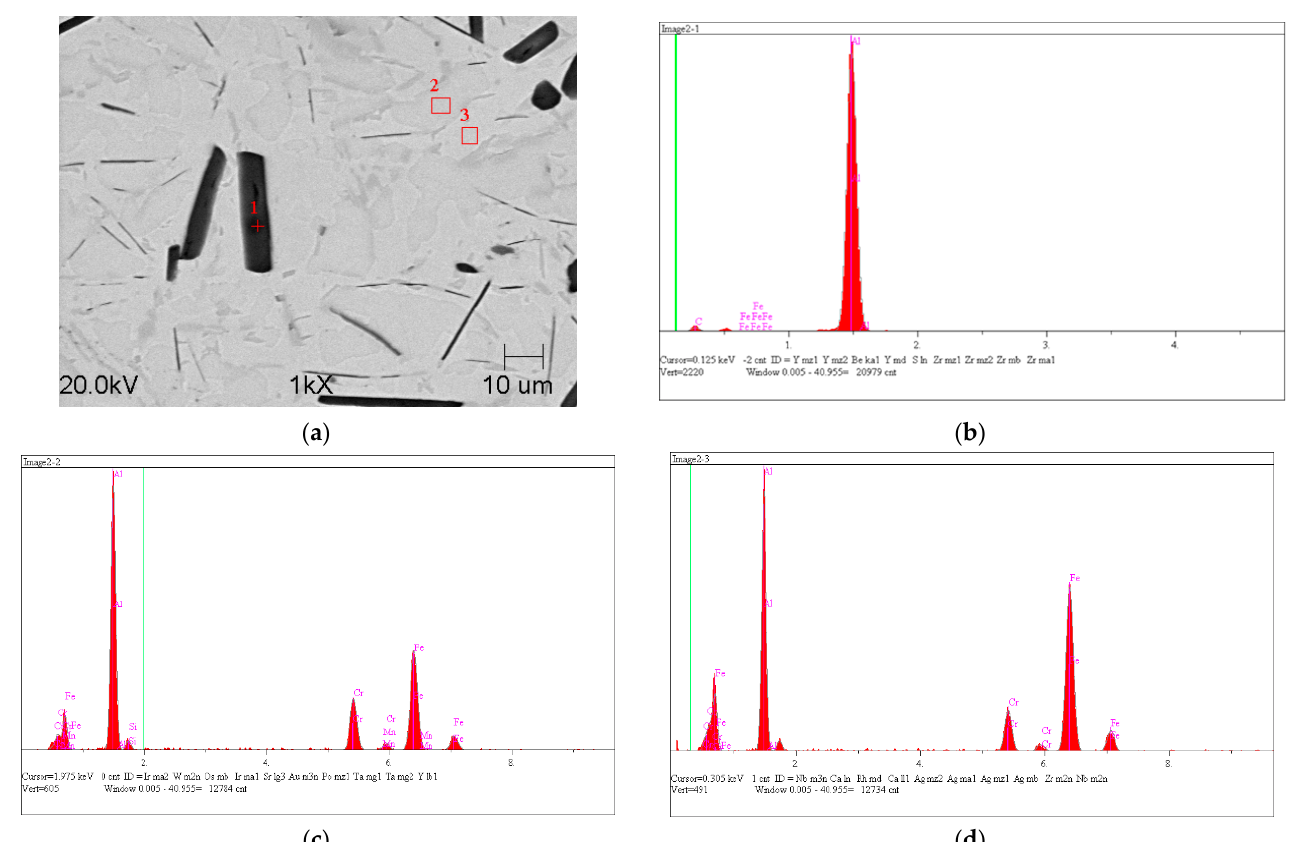
Figure 12. SEM microstructure with marked EDS chemical analysis points of a sample made from high-aluminum cast iron after heat treatment ( a ) and EDS X-ray microanalysis of carbide precipitation: No. 1 ( b ), No. 2 ( c ), No. 3 ( d ).